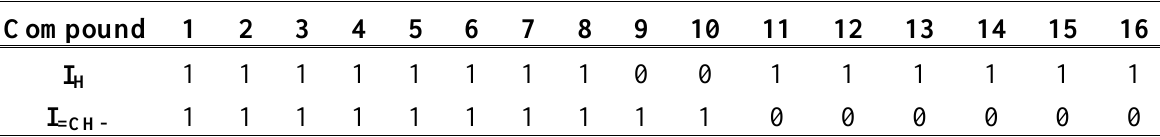
Table 8. Matrix for Free Wilson